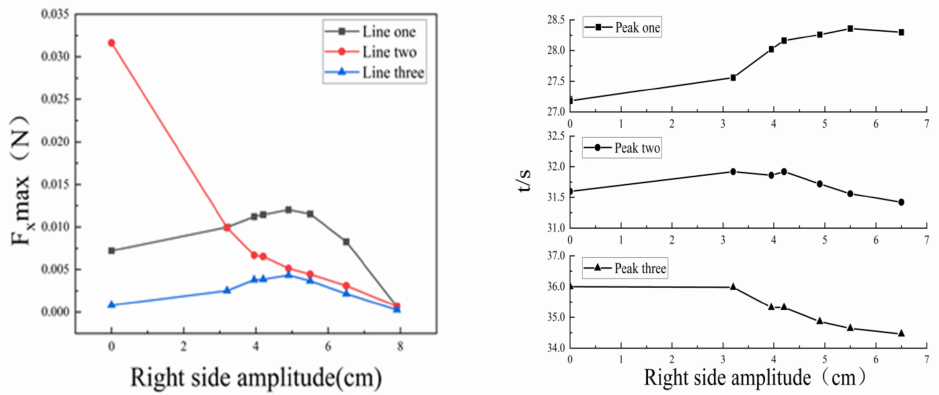
Figure 13. Comparison of horizontal force extremes and time of